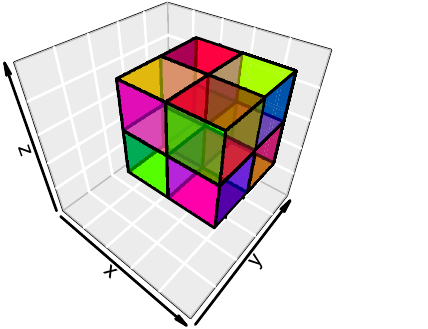
Figure 3: To understand the picture, there are six colors: red and yellow on the xy - plane, green and magenta on the xz - plane, and brown and blue on the yz - plane. Each cube has two faces with the same color, by projection onto that